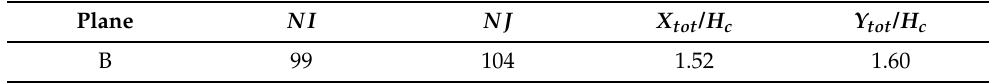
Table 2. Basic geometric and grid parameters: NI and NJ are the numbers of the grid lines with respect to the x and y direction, while X tot and Y tot are the x and y dimensions of the computational domain. Plane